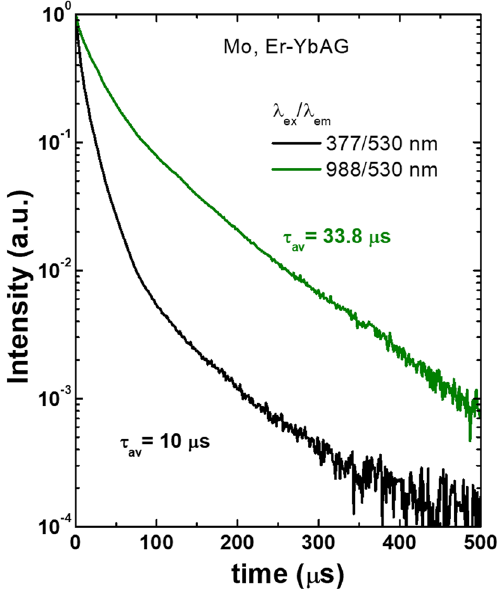
Figure 5. Er emission decays in Er, Mo -YbAG measured at 530 nm under direct (377 nm) and upconversion excitation (988